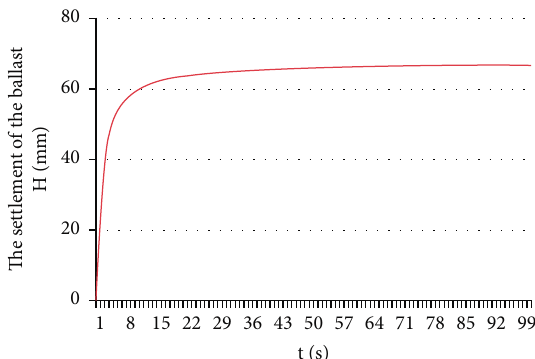
Figure 16: The curve of the settlement of the integrated ballast with the time.